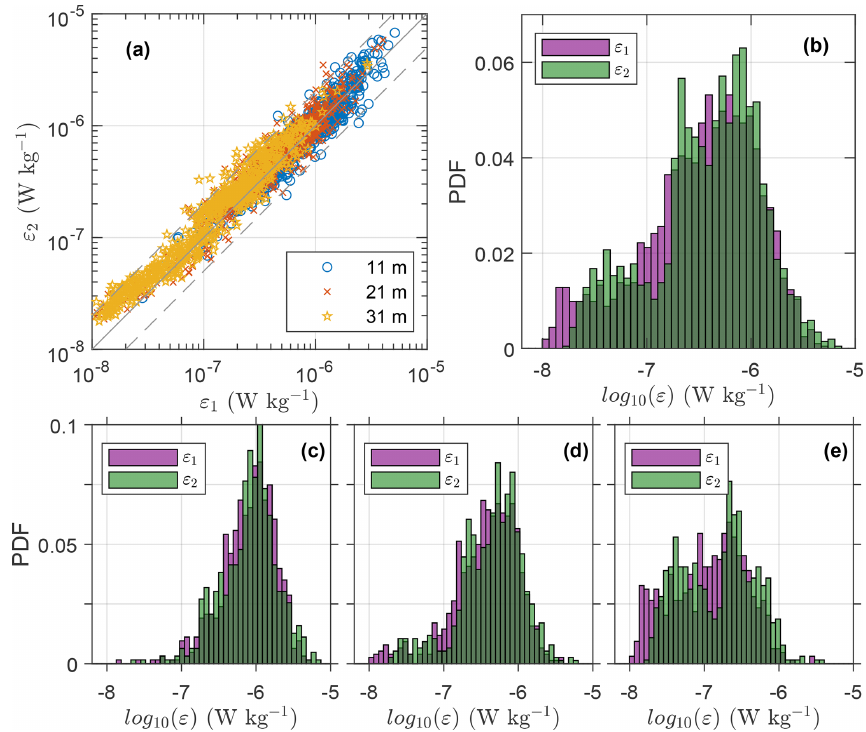
Figure 7. Comparison of dissipation estimates from two probes. (cid:15) 1 is from ∂w/∂x measurements, and (cid:15) 2 is from ∂v/∂x . (a) Scatter plot of dissipation estimates from each probe, color-coded with respect to measurement depth. Gray dashed lines span the agreement within a factor of 2. (b) Probability distribution function (PDF) for dissipation rates from each probe using data from all depths. (c, d, e) PDFs for dissipation rates from each probe using data from transects at 11, 21 and 31m depths, respectively.